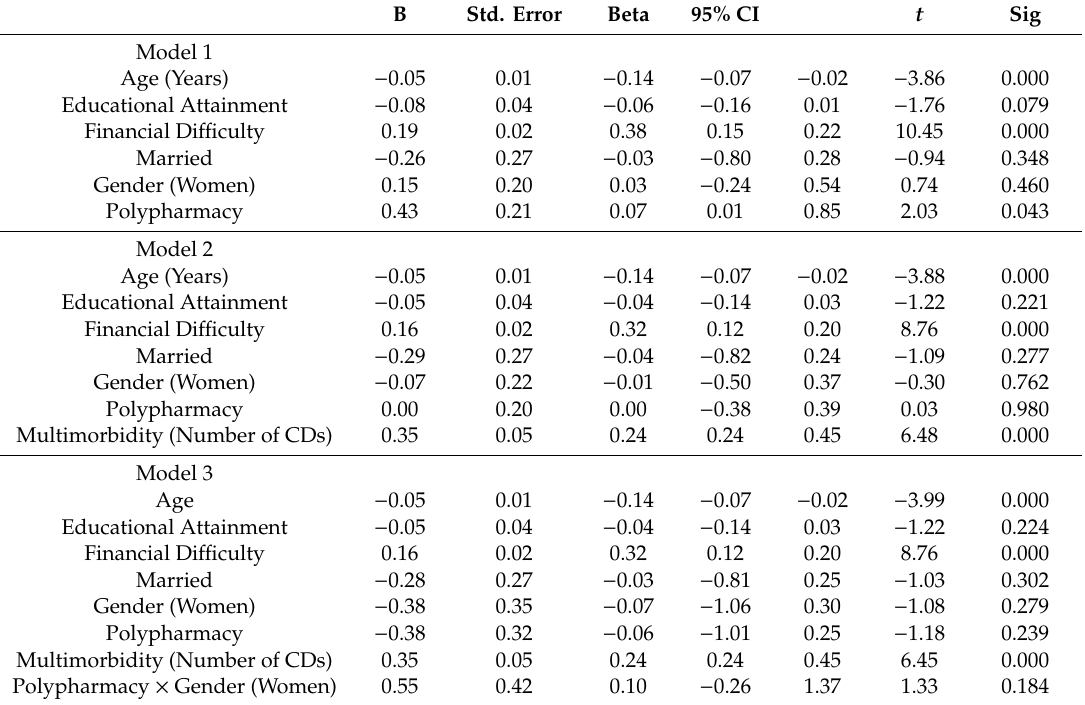
Table 4. Linear regressions on the associations between gender, polypharmacy, and depression in the pooled